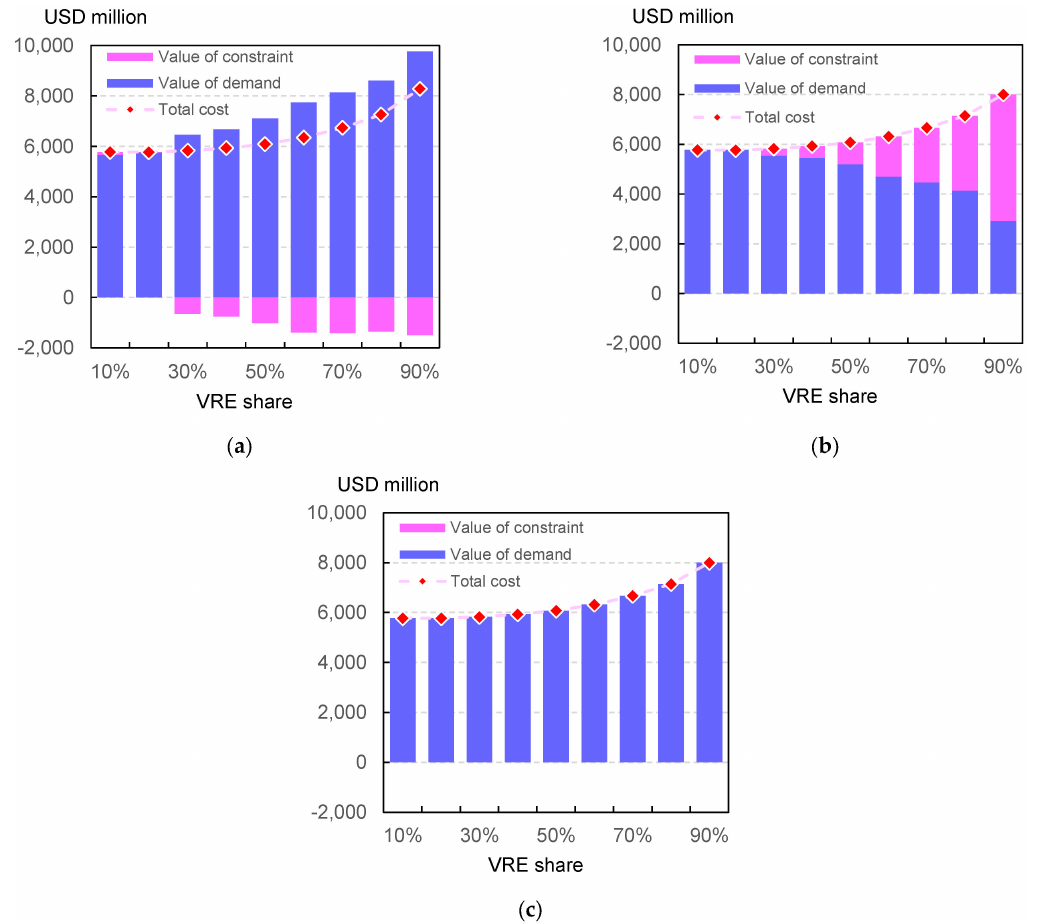
Figure A1. Total values and costs. ( a ) Case A; ( b ) Case B; ( c ) Case C.